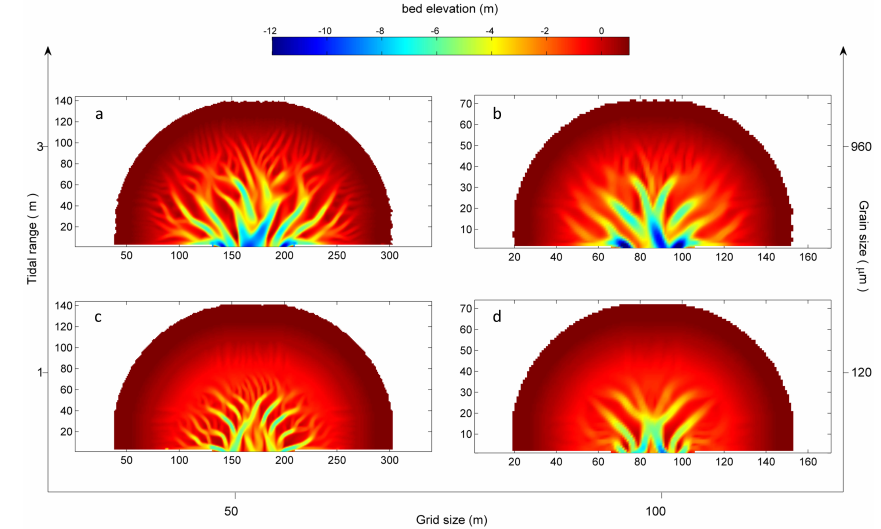
Fig. 1. Numerical simulations in the inner part of the basin using a grid size of 50m and 100m. (a) Simulations with TR = 3m D 50 = 960µm and grid size = 50m (b) with TR = 3m D 50 = 960µm and grid size = 100m. (c) Simulations with TR = 1m D 50 = 120µm and grid size = 50m (d) with TR = 1m D 50 = 120µm and grid size =